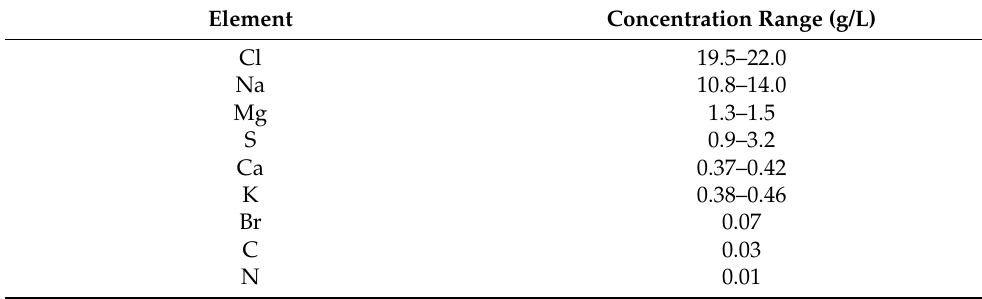
Table 2. Average chemical composition of seawater. Data modified from Ref.